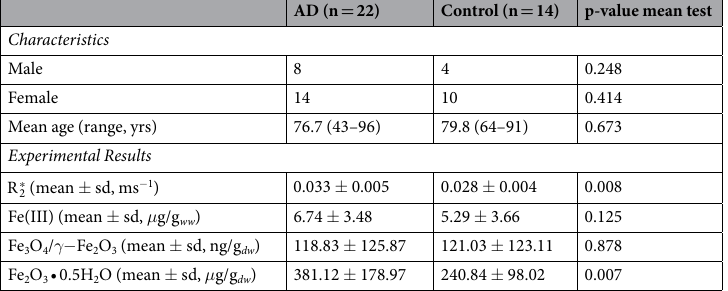
Table 1. Summary of sample characteristics and experimental results. A chi-square test was used to assess differences in gender between AD and control group. A Mann-Whitney U test was used to assess differences in age between AD and control group. Student’s t-test was performed to test differences in the means of the measured iron concentrations. Statistical tests were repeated with and without the presence of the outliers, and the same conclusion about the significance of the test was reached. The index dw refers to dry weight, and ww refers to wet